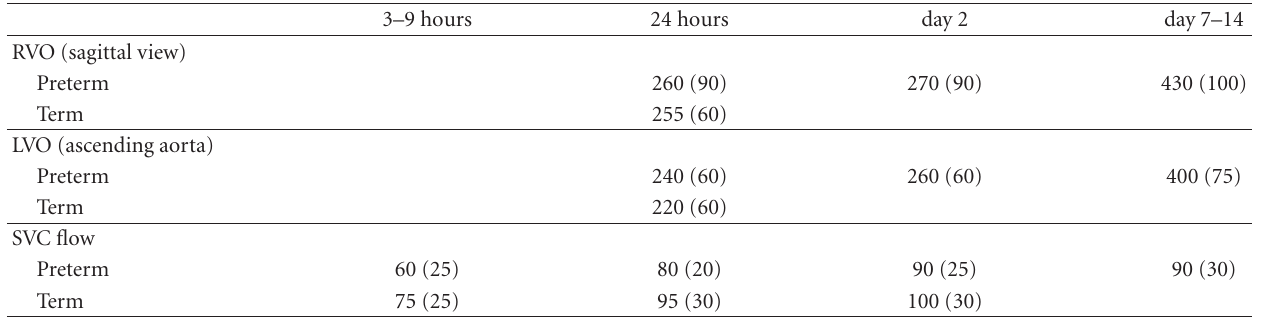
Table 6: Mean and SD of central blood flow values using the methodology as described by Evans and Kluckow [7, 8].